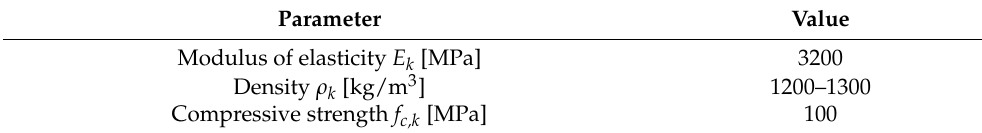
Table 3. Technical data of epoxy resin